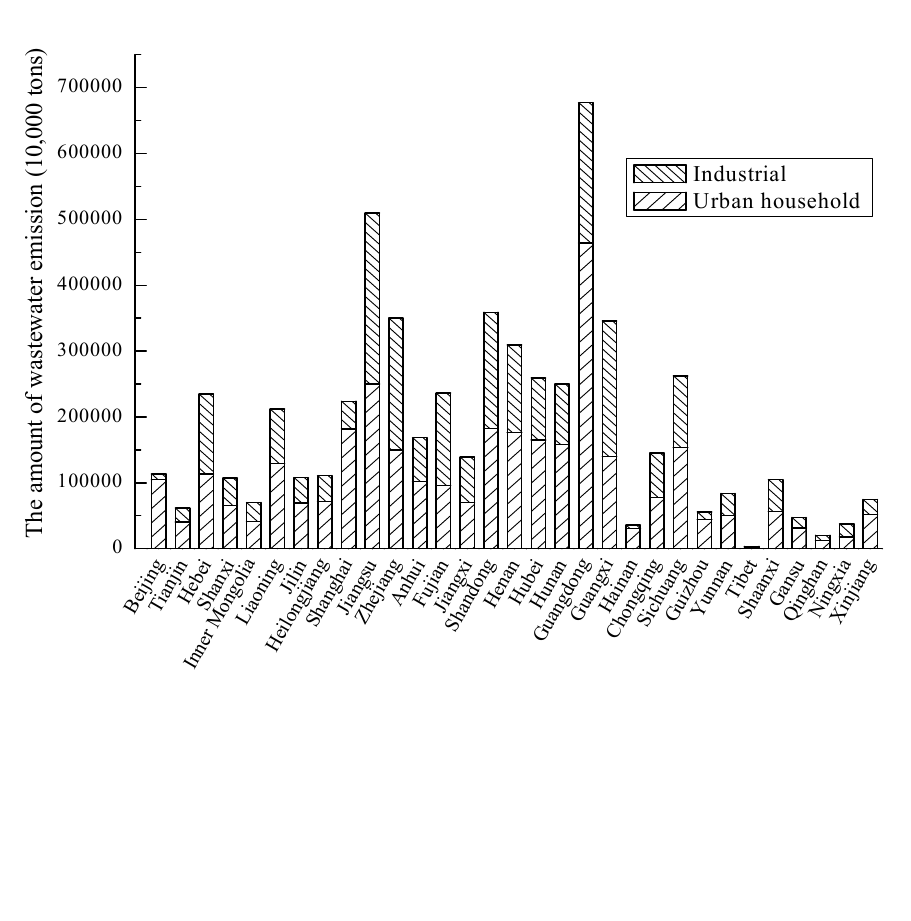
Figure 3. The distribution of wastewater emissions in